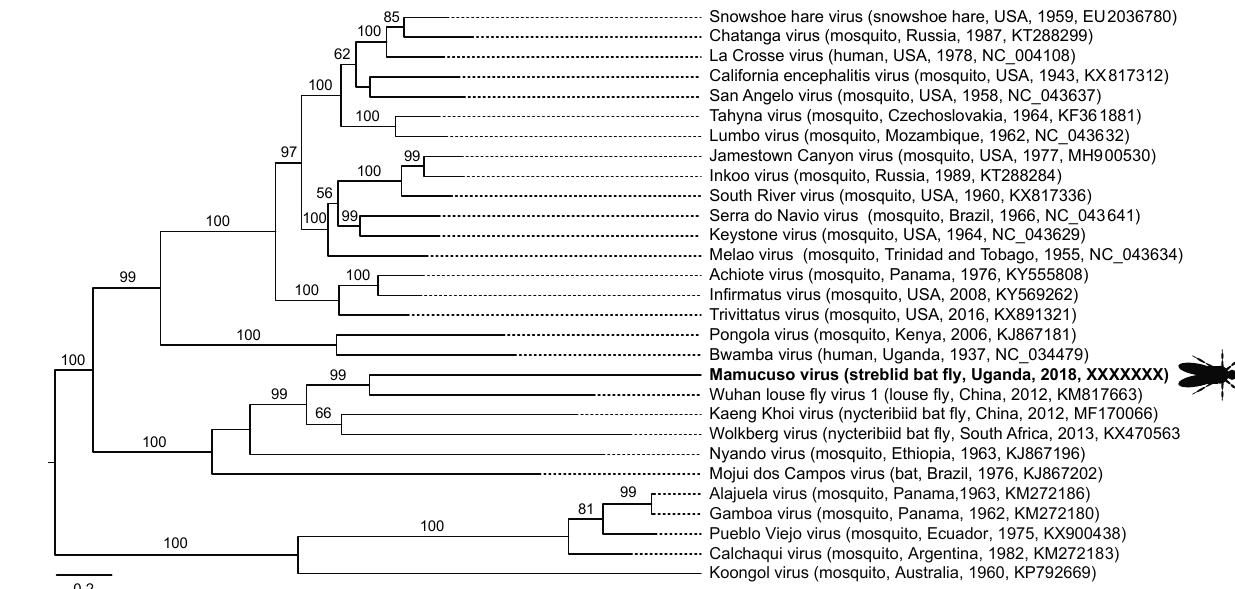
Figure 5. Maximum likelihood phylogenetic tree of orthobunyaviruses based on L (polymerase) gene sequences. Virus names are followed (in parentheses) by host, country, year of collection, and GenBank accession number. Mamucuso virus, identified in the present study, is shown in bold type with silhouette of streblid bat fly. Numbers beside branches represent statistical confidence in clades, based on 1000 bootstrap replicates; only bootstrap values ≥ 50% are shown. Scale bar = nucleotide substitutions per site.